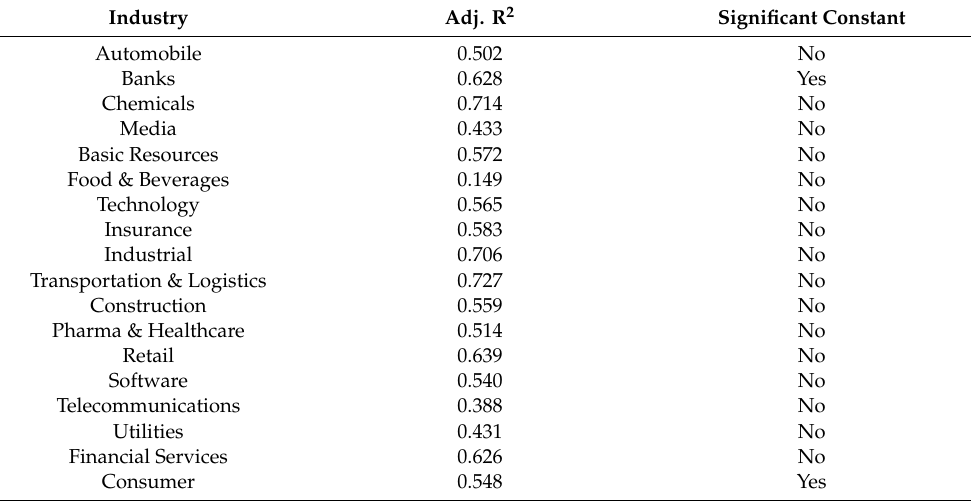
Table 2. Single factor models for 18 German industry